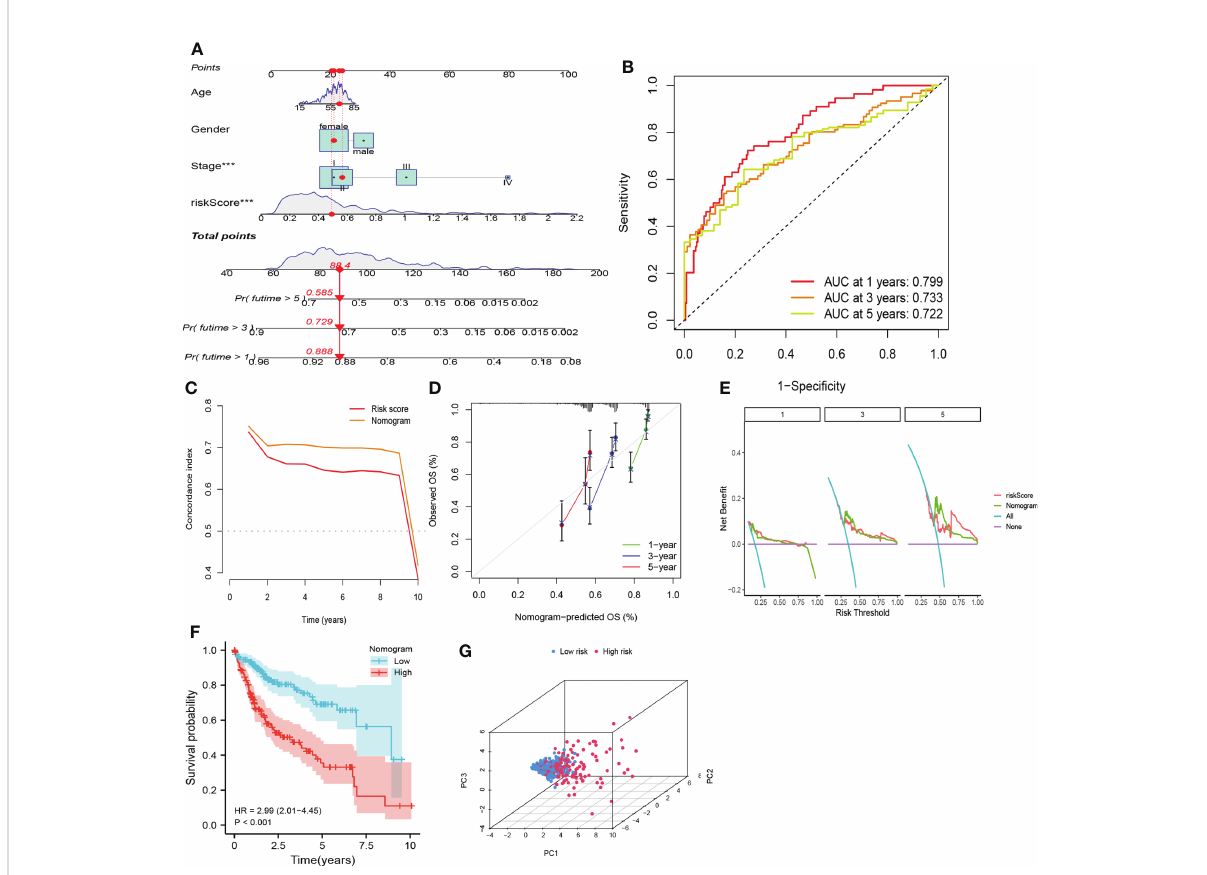
FIGURE 7 Nomogram based on CRFs, gender, and stage. (A) Nomogram. (B) timeROC curve of the nomogram. (C) C-index curve of the nomogram. (D) Calibration curve of the nomogram. (E) Decision curve analysis of the nomogram. (F) PCA curve of the nomogram. (G) KM curve of the